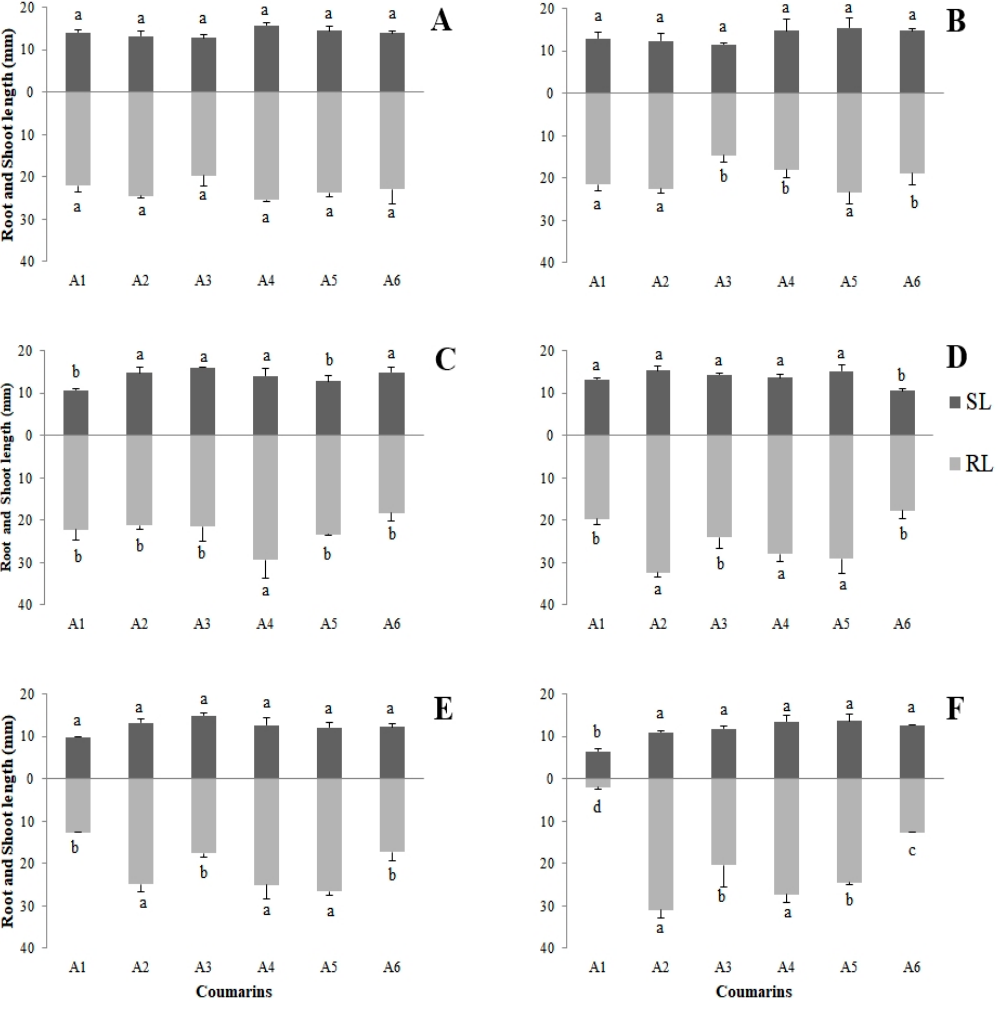
Figure 2. Averages obtained for root length (RL) and shoot length (SL), in millimeters, for Lactuca mL − 1 ; ( D ) 200 µg mL − 1 ; ( E ) 400 µg mL − 1 ; ( F ) 800 µg mL − 1 . Columns in the same color followed by the ( D ) 200 µ g mL − 1 ; ( E ) 400 µ g mL − 1 ; ( F ) 800 µ g mL − 1 . Columns in the same color followed by the